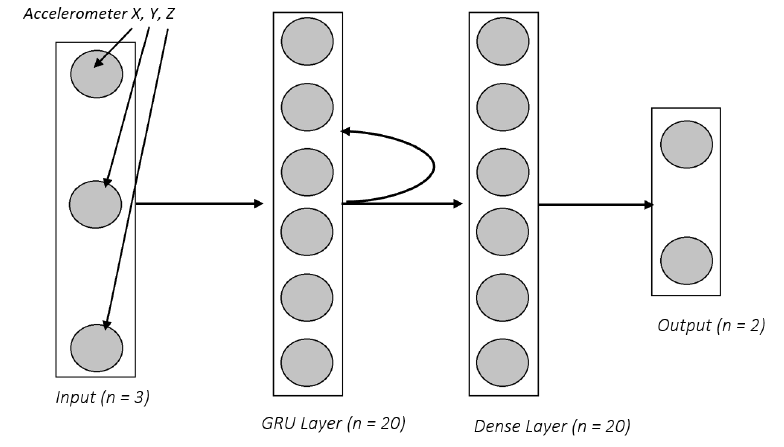
Figure 4. RNN Model